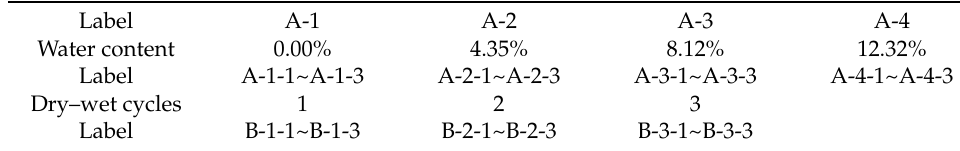
Table 1. Specimen numbering sheet.